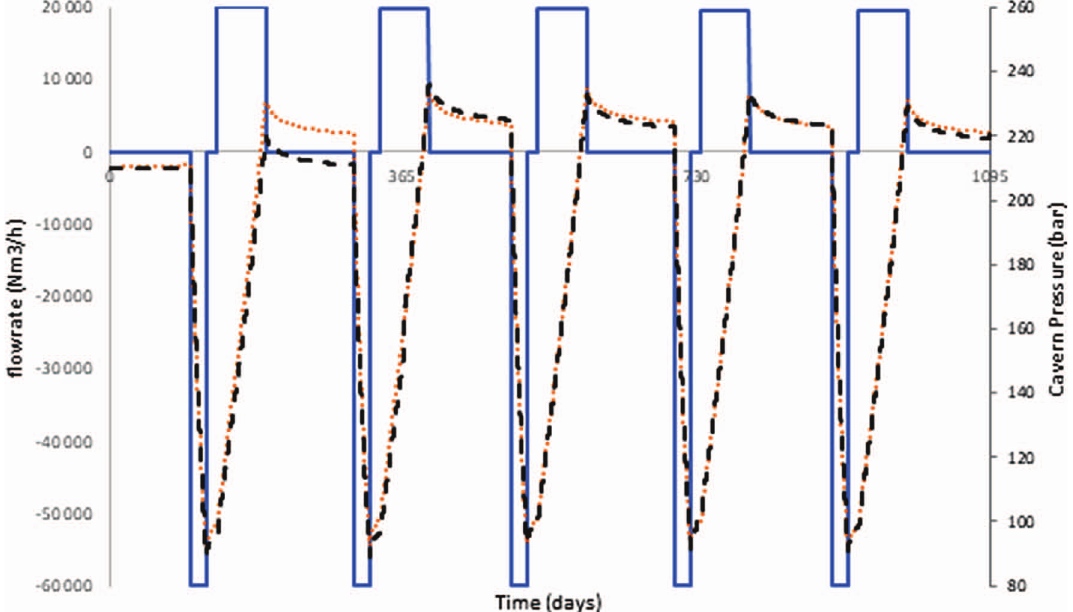
Fig. 8. Geomechanical coupling: annual update of the cavern volume (dashed line), update of the volume at each time step (dotted